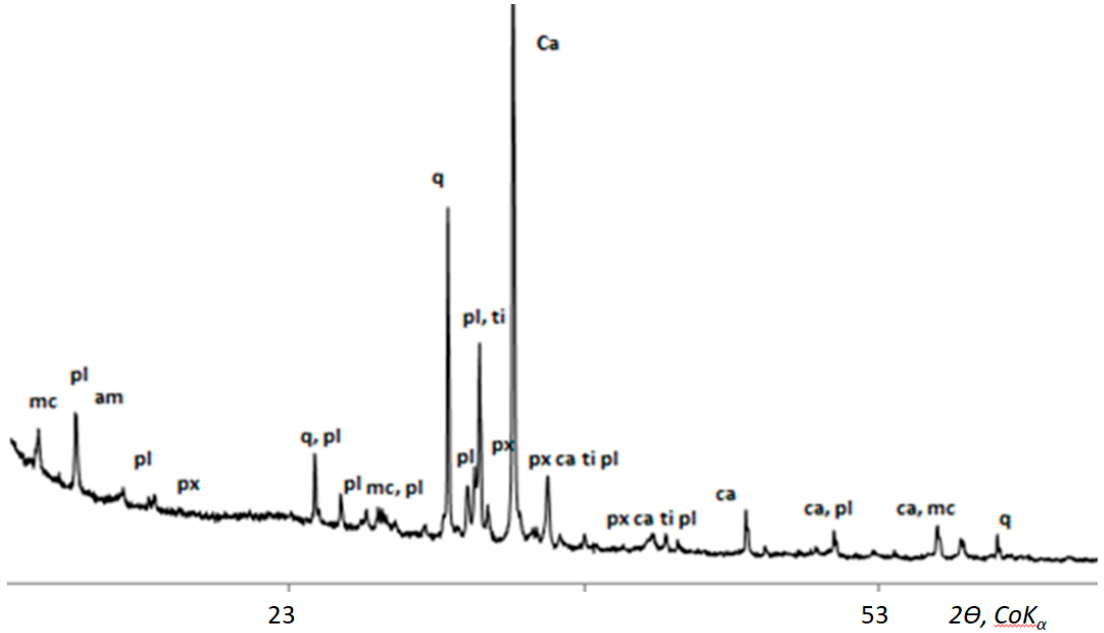
Figure 4. X-ray diagram of silicate minerals grains in biofilm with a predominance of microscopic fungi on the surface of a homogeneous calcite marble: quartz (q), calcite (Ca), plagioclase (pl), mica (mc), pyroxene (px), titanite (ti), amphibole